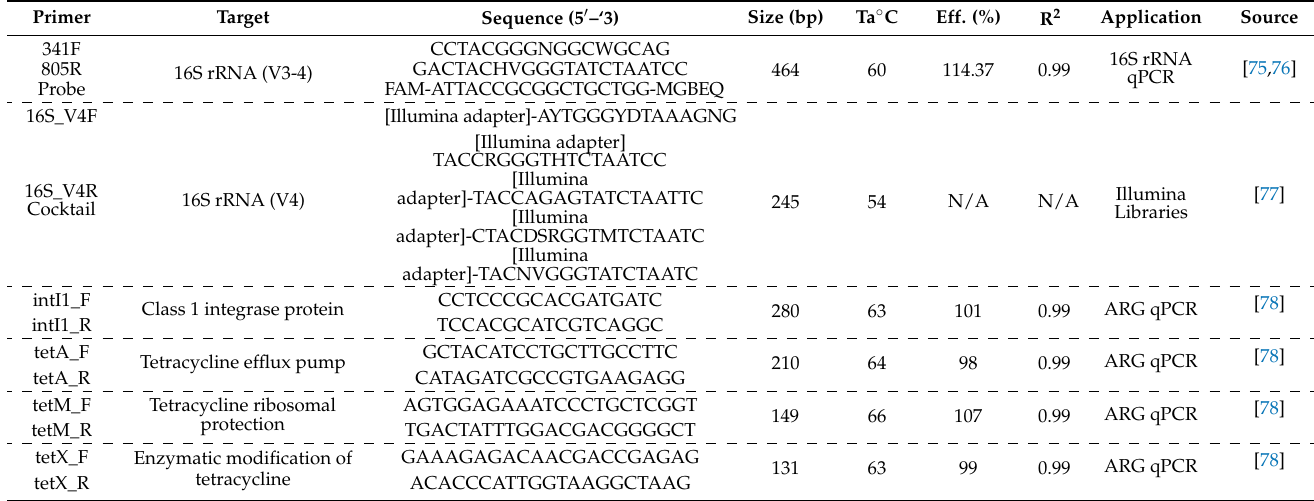
Table 4. Primer sets used in this